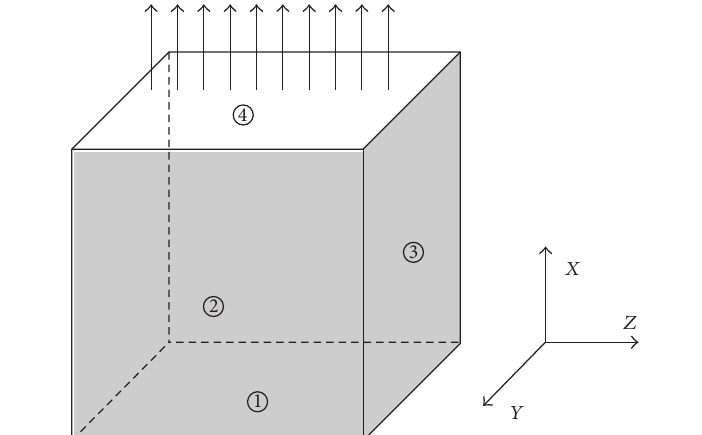
Figure 4: Testing element.